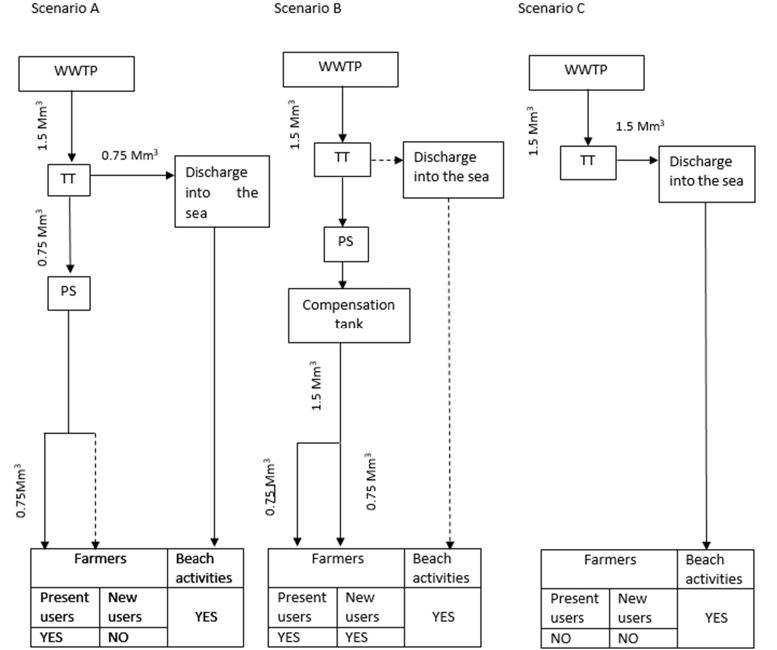
Figure 3. Schematic of three scenarios examined. Dotted lines indicate flows that do not occur in the specific scenario. Water amounts to irrigation (0.75 Mm 3 ) are those evaluated at Section